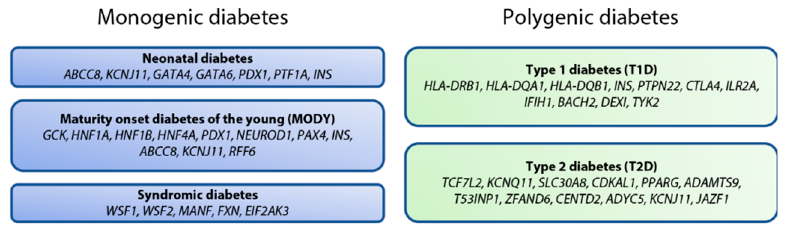
Figure 2. Summary of some of the genes involved in monogenic diabetes, and a small sample of risk loci identified for polygenic diabetes (>50 for T1D, >500 for T2D).